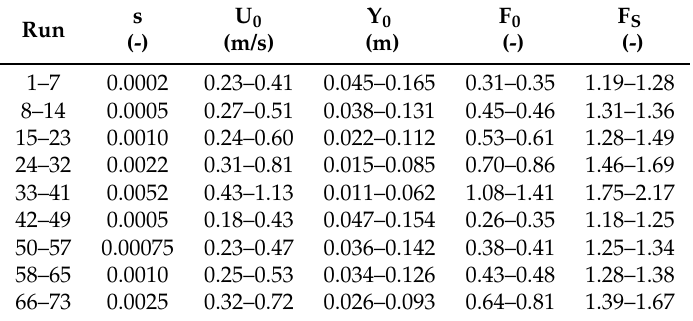
Summary of experimental conditions. Runs 1 to 41 are performed in the long flume, runs 42 to 73 are performed in the short flume; F S is the surge Froude number defined by Equation (13). s U